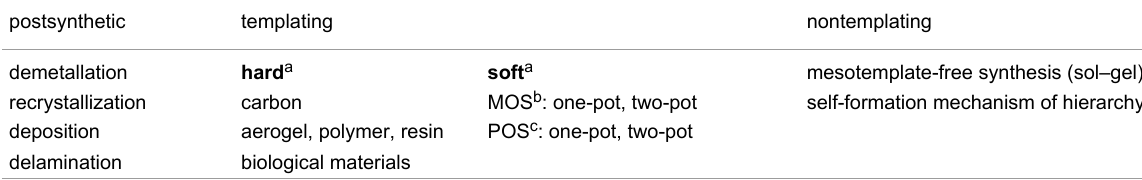
Table 1: Overview of the most important synthesis strategies for the formation of combined zeolitic/mesoporous materials.